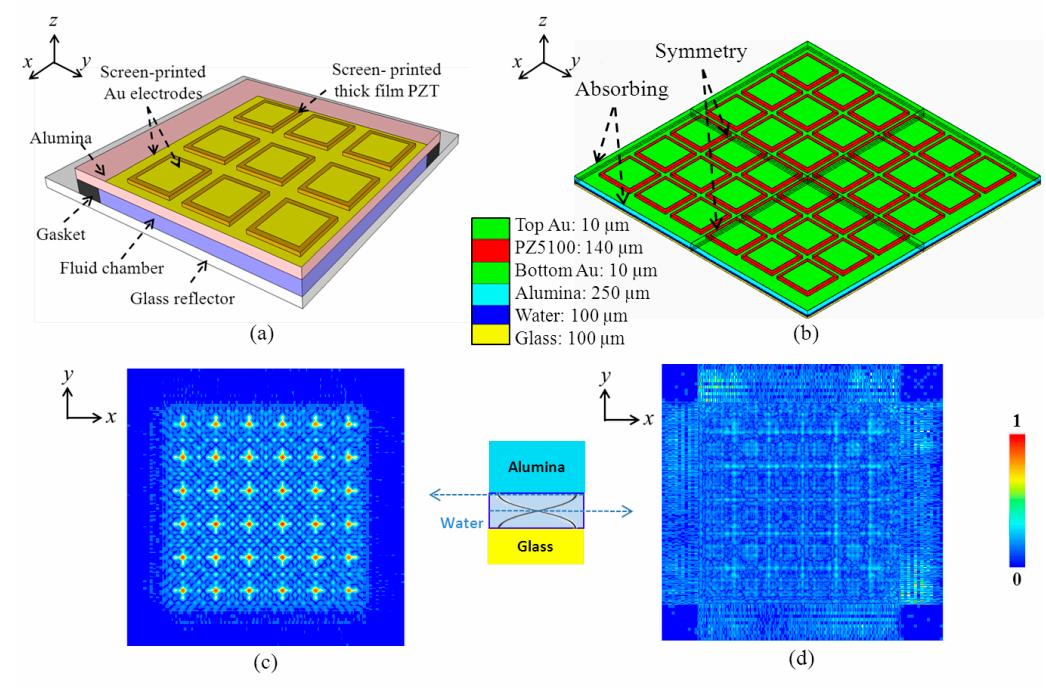
Figure 12. ( a ) Cross-sectional diagram of quarter of a multilayer USM device with a screen-printed thick-film PZT 2-D matrix array; ( b ) 3-D FEA model and layer thicknesses of 2-D matrix thick film array manipulator; ( c ) normalized pressure distribution near the anti-nodal and ( d ) nodal planes in water beneath the alumina substrate of the 2-D array with all 36 elements active. © 2013 IEEE. Reprinted with permission from